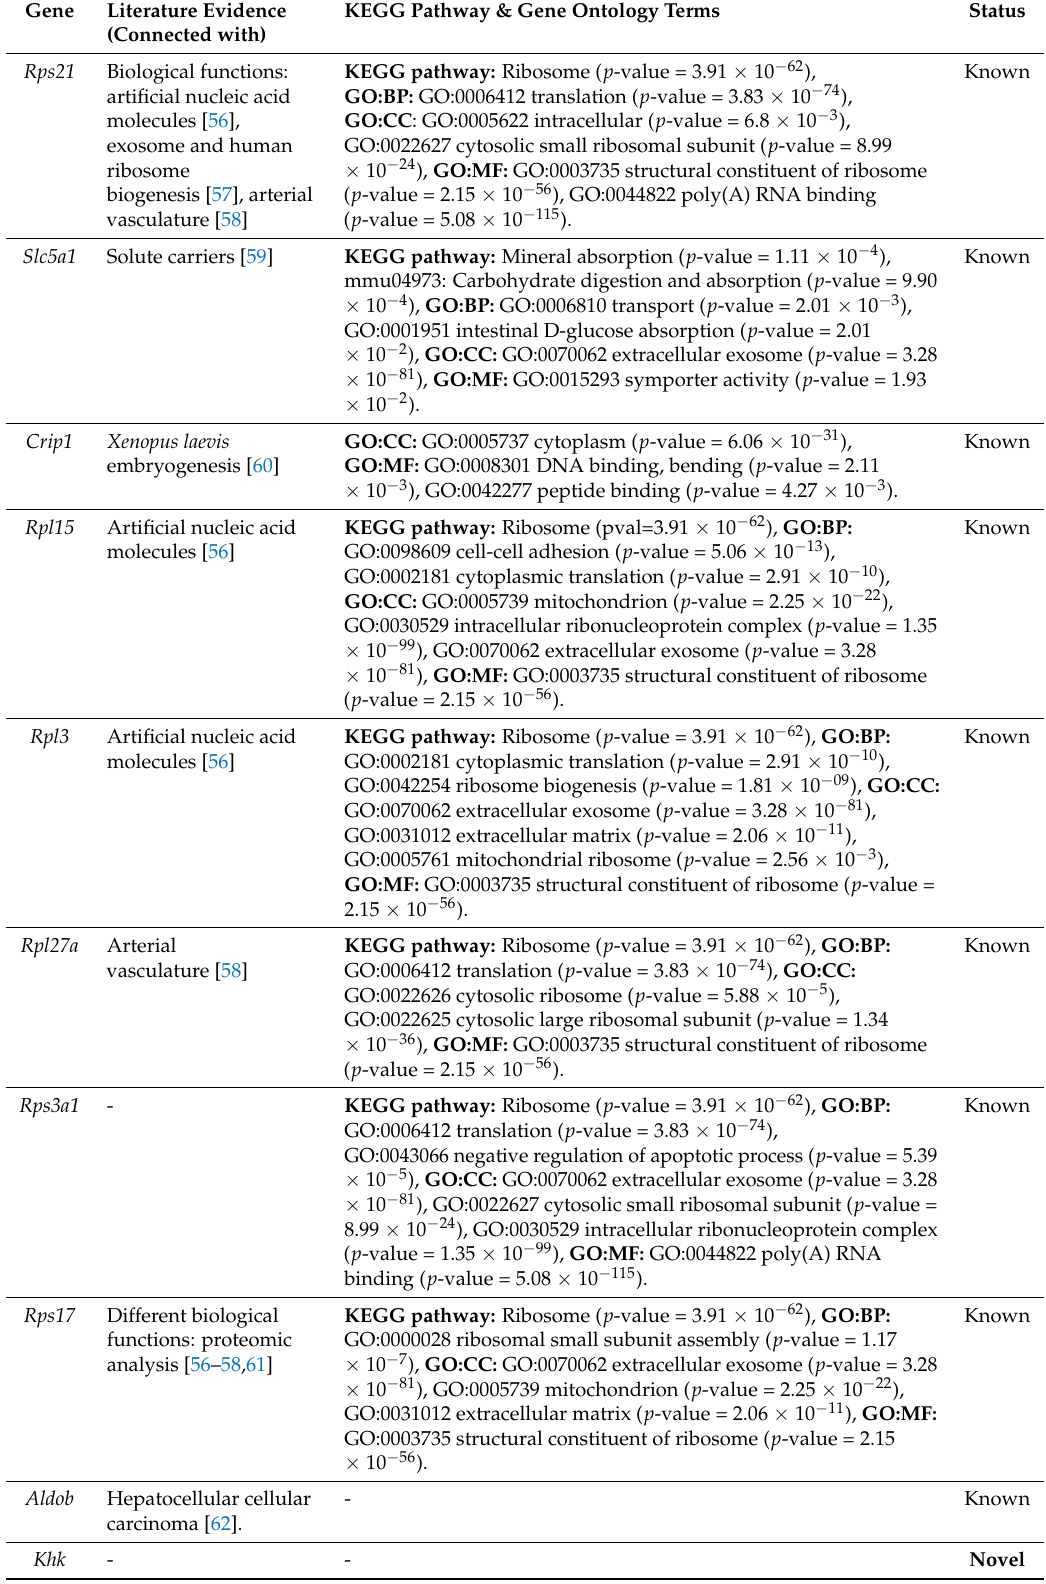
Table 6. Evaluation of the top ten gene markers through literature evidence, KEGG pathway and Gene Ontology